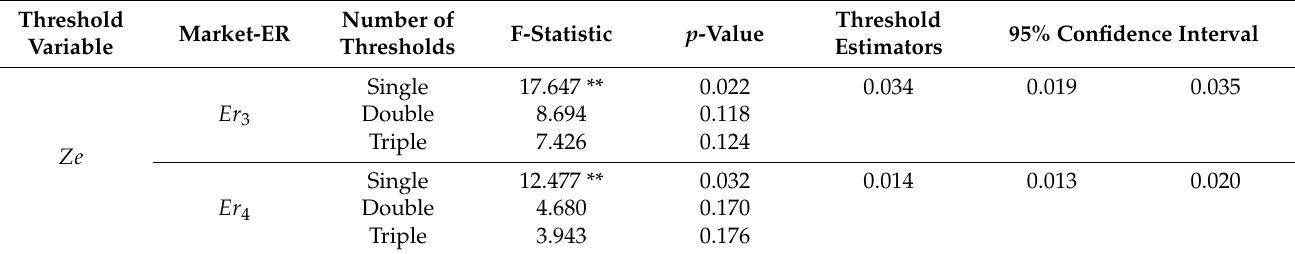
Table 8. Threshold effect test: